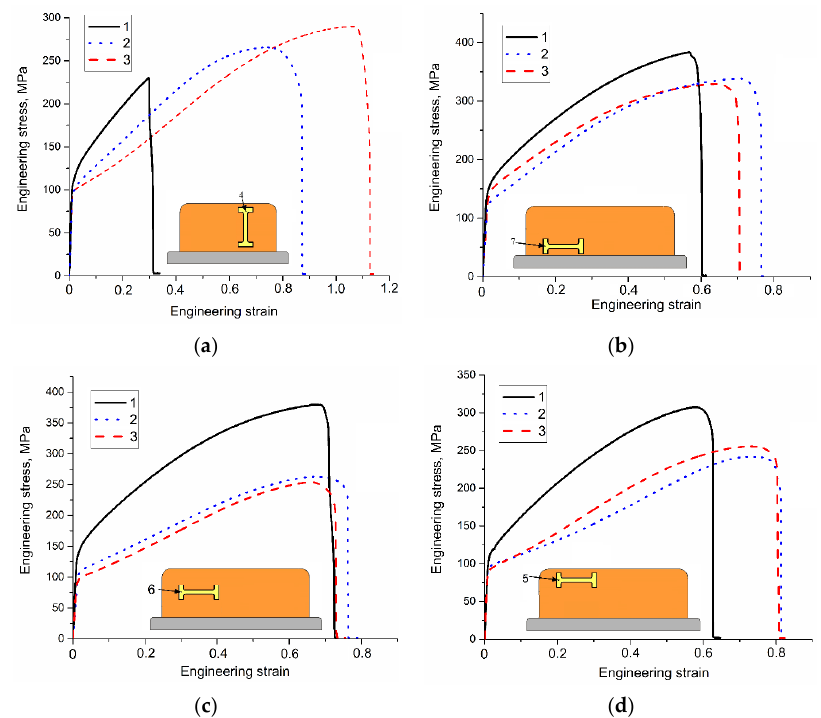
Figure 12. The “stress-strain” curves obtained from tensile tests on Cu-7.5wt.%Al samples 4 ( a ), 7 ( b ), 6 ( c ) and 5 ( d ). EBAM regime: 1—0.21 kJ/mm, 2—0.255 kJ/mm, 3—0.3 kJ/mm.